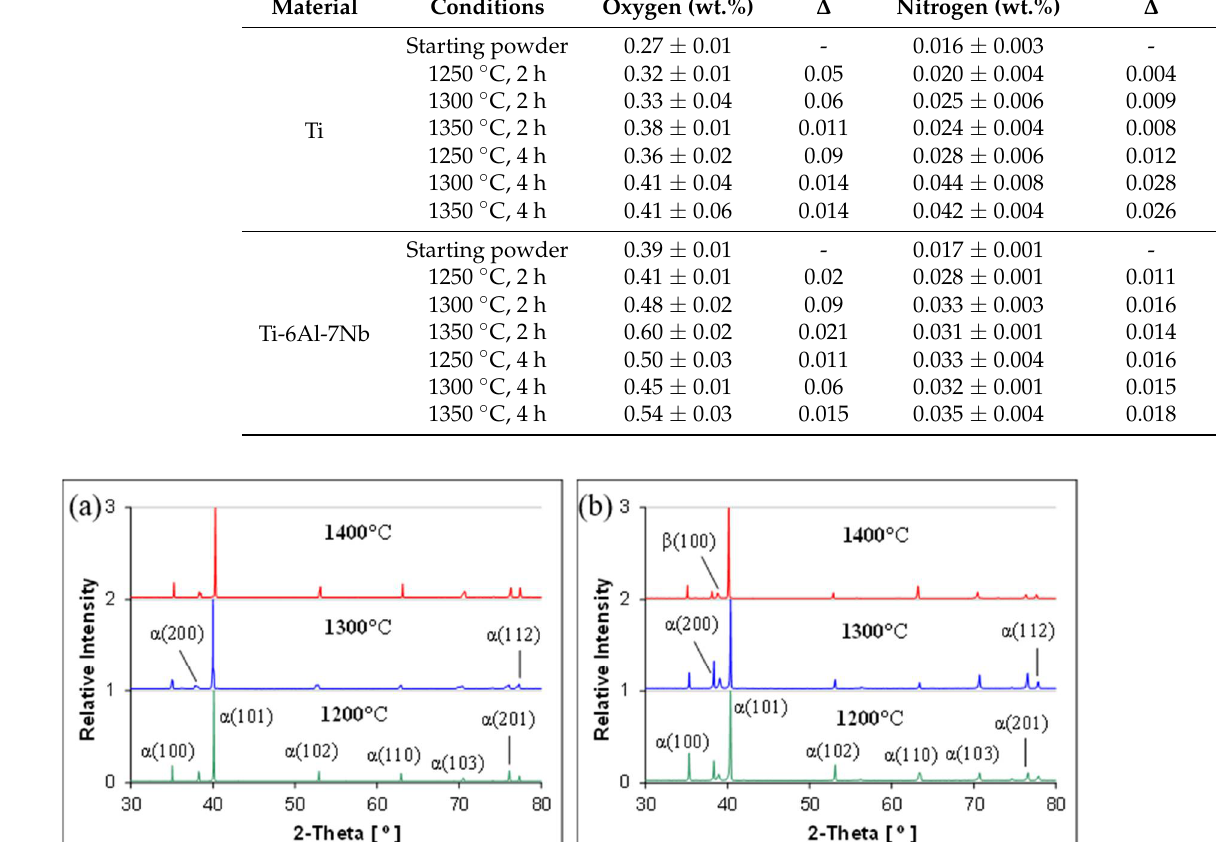
Table 1. Chemical analysis of the P/M Ti and Ti-6Al-7Nb alloy sintered using different combinations of sintering temperatures and dwell times.